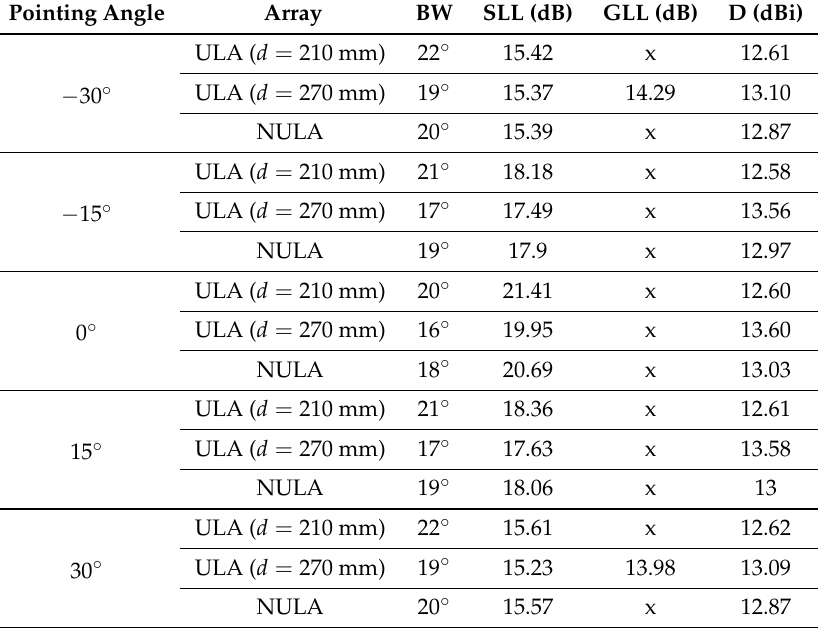
Table 6. Main characteristics of the azimuth plane radiation patterns generated with the SLL control weighting vector of the ULAs with inter-element spacings of 210 mm and 270 mm and the NULA designed in Section 3.2, for N = 5 commercial antennas. The considered steering angles are φ = [ − 30, − 15,0,15,30 ] ◦ .